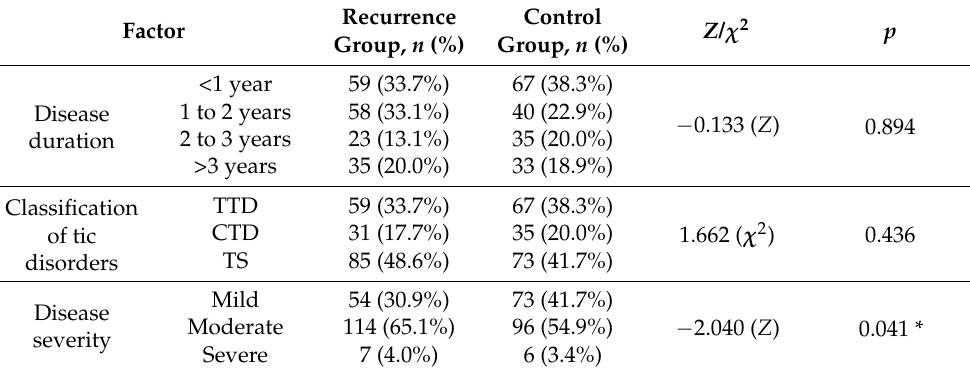
Table 7. Correlation between disease duration, tic classification, disease severity, and recurrence of tic disorders (modifiable